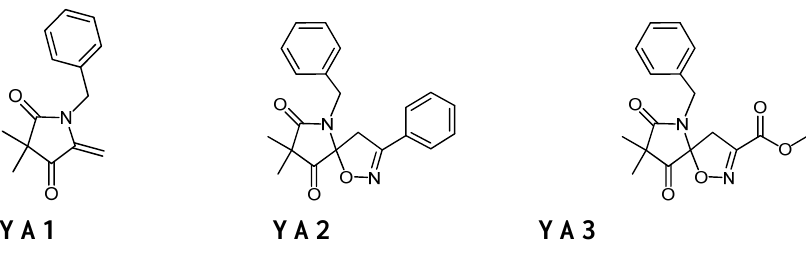
Figure 1. Chemical structures of the novel pyrrolidine and spiroisoxazoline type compounds.